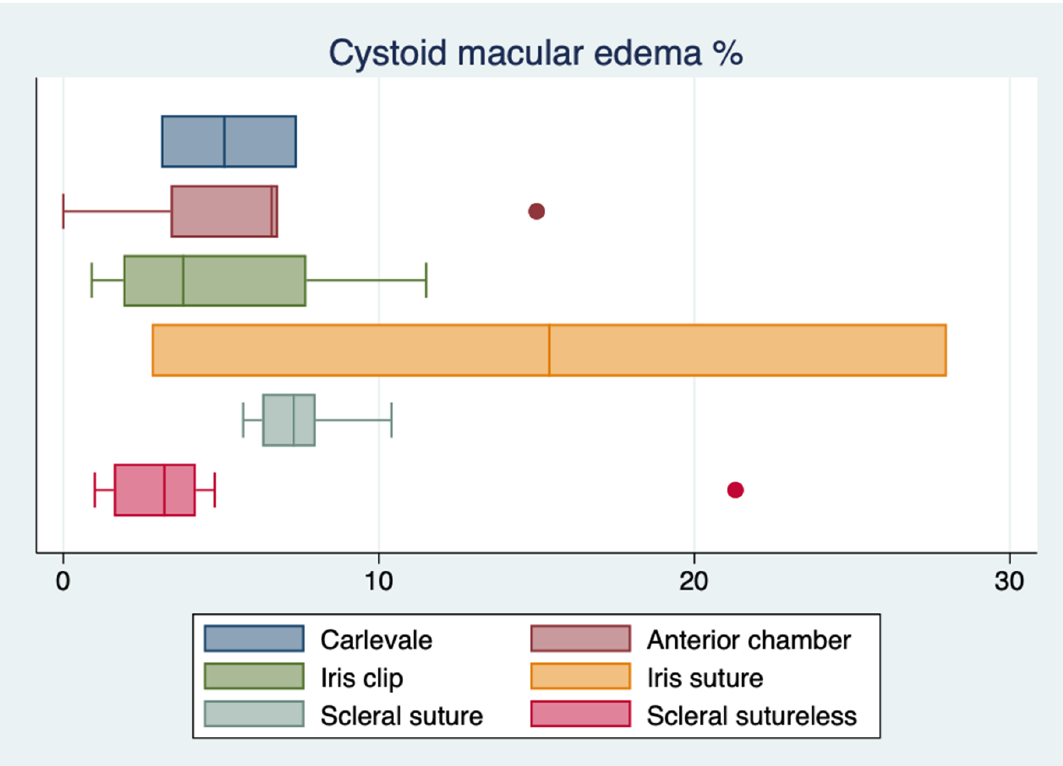
Figure 2. Boxplot of cystoid macular edema reported incidences.